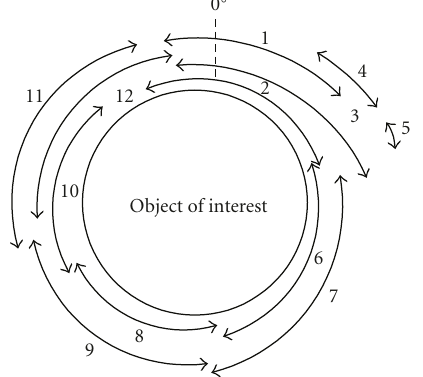
Figure 10: An example to illustrate the proposed algorithm.